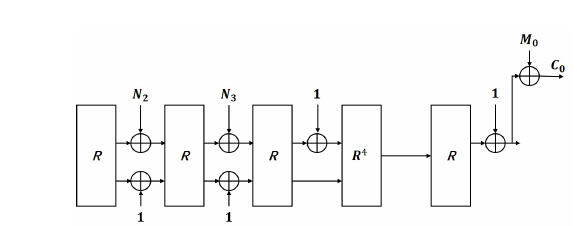
Figure 8: Cube tester for 4-blank-round